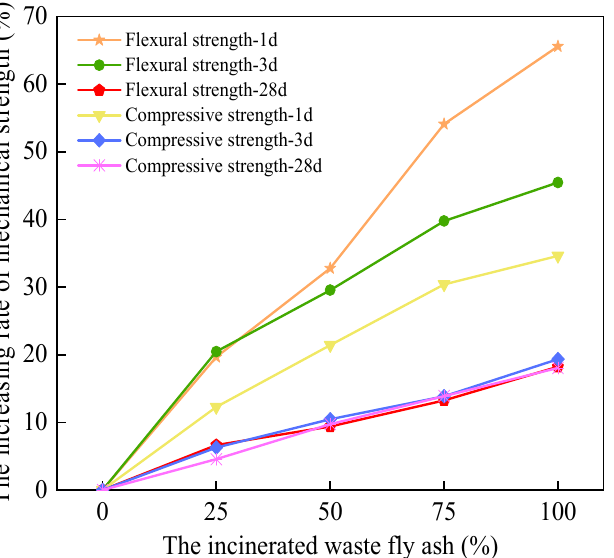
Figure 7. The increasing rates of mechanical strengths of RPC with conventionally treated incinerated waste fly ash.